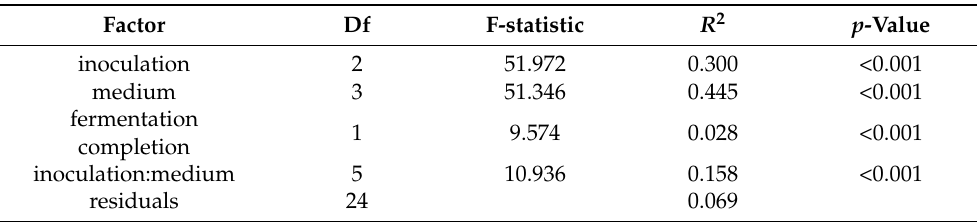
Table 4. PERMANOVA of the volatile compound concentrations regarding three external variables, medium (JN, JS, SN, and SS), inoculation (EC, MSPC, and N), and fermentation completion